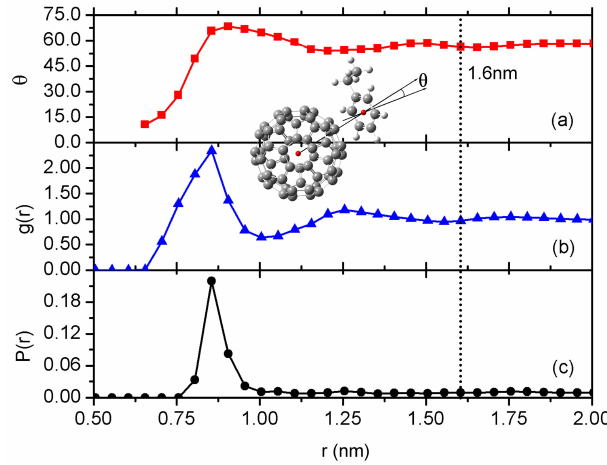
Figure 2. ( a ) The orientation angle of phenyl rings around C 60 ; ( b ) the RDF of phenyl rings on melt PS chain backbone around the C 60 NP surface; and ( c ) the distribution of paralleled phenyl ring pairs around C 60 . Note that all the data in these figures are plotted as a function of the distance to the centre-of-mass of the C 60 NP. The inset shows the definition of the orientation angle of the phenyl